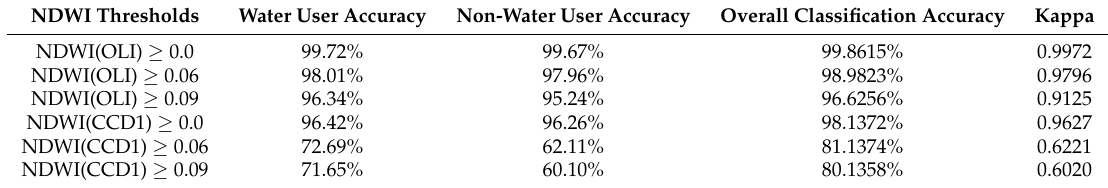
Table 11. The classification accuracy evaluation table at a different threshold. NDWI Thresholds Water User Accuracy Non-Water User Accuracy Overall Classification Accuracy Kappa NDWI(OLI) ≥ 0.0